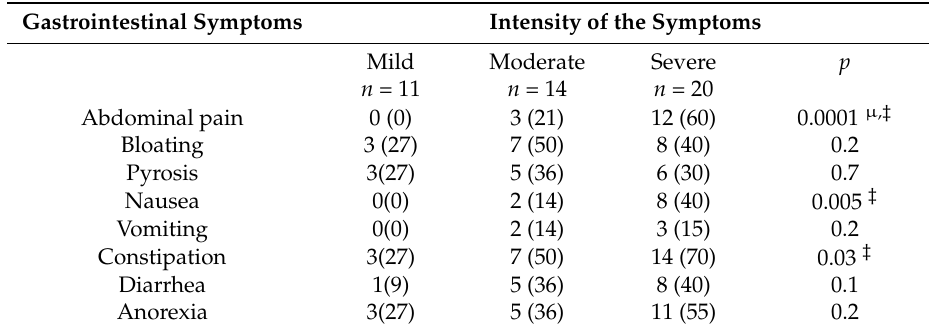
Table 2. Prevalence and severity of Gastrointestinal